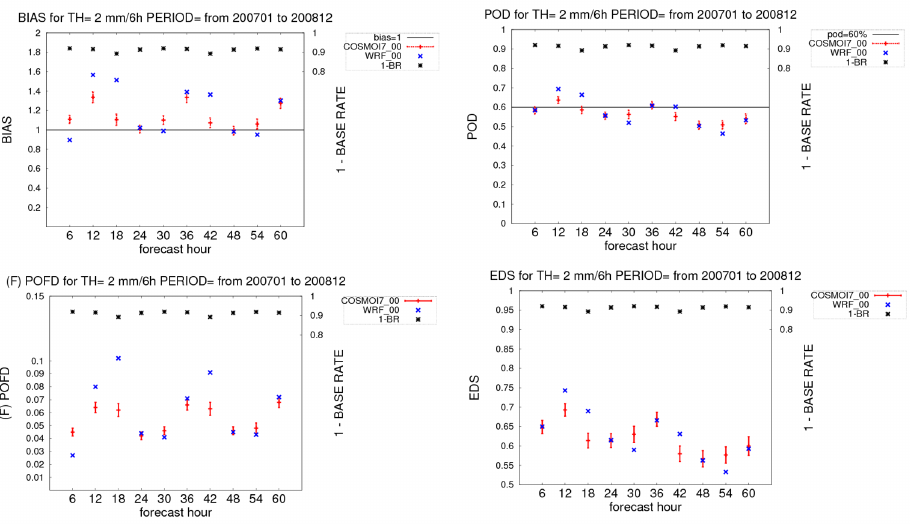
Fig. 10. Diurnal cycle: BIAS, POD, POFD and EDS for 2mm6h − 1 threshold. The dashed red lines and the blue daggers represent COSMO-I7 and WRF respectively. The Base Rate (stars) is plotted for each threshold.